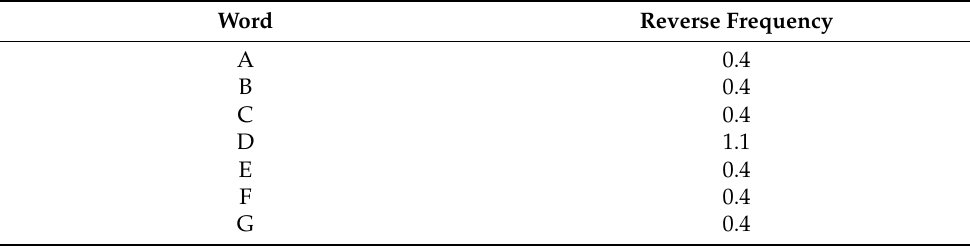
Table 5. Reverse frequency of feature words in